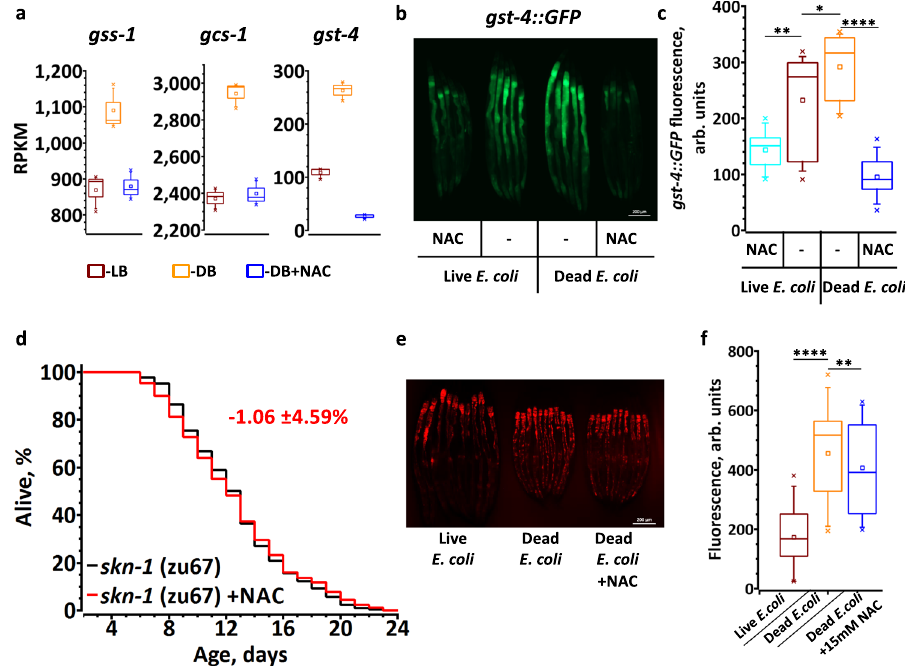
Fig. 4 Thiols shorten C. elegans lifespan by inhibiting SKN-1-dependent transcription. a Regulation of representative SKN-1 dependent genes by LB, DB or DB + NAC. Graphs show RPKM of three independent experiments from RNA-seq. See Supplementary Data 1 for statistics. b , c Representative fl uorescent image and quanti fi cation demonstrating that skn-1 -dependent transcription is downregulated by thiols. L4 stage gst-4::GFP worms transferred to live or dead bacteria diet ±15 mM NAC and incubated for 5 days prior to imaging. n = 60 – 65 worms over three independent experiments. See also Supplementary Table 5. d NAC (5 mM) does not shorten the lifespan of skn-1 worms. Average percentage change ±SD of the lifespan relative to untreated control is indicated in red ( n = 188(untreated), 177(5 mM NAC)). e , f Representative fl uorescent image and quanti fi cation demonstrating ROS staining by DHE in live worms. WT animals were reared on LB, DB or DB + 15 mM NAC and stained with DHE at day 3 of adulthood. n = 91 – 94 worms over three independent experiments. See also Supplementary Table 6. In a , c , f the box plots indicate median (middle line), 25th, 75th percentile (box) and 5th and 95th percentile (whiskers) as well as maximum, minimum and mean (single points). In all graphs p values are: n.s. not signi fi cant; * p < 0.05; ** p < 0.01; *** p < 0.001; **** p < 0.0001; two-tailed t